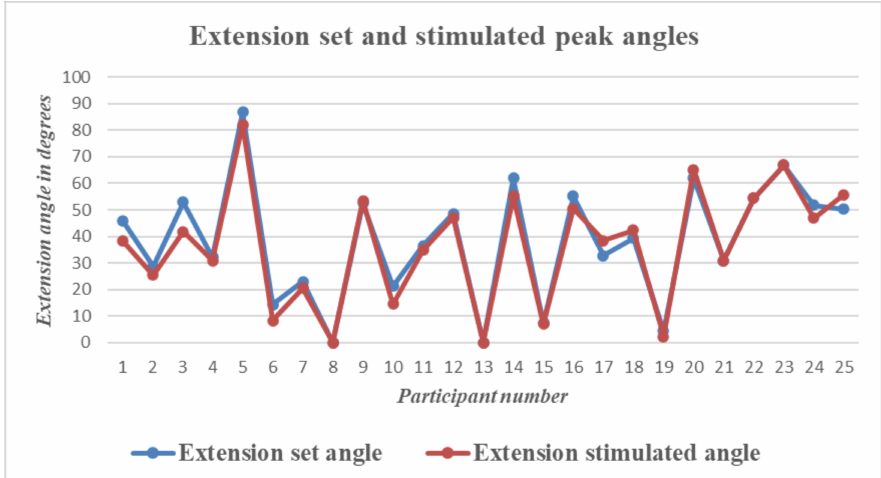
Figure 9. Wrist Flexion—Graph showing differences between set and stimulated wrist flexion angle peaks for all 25 participants.